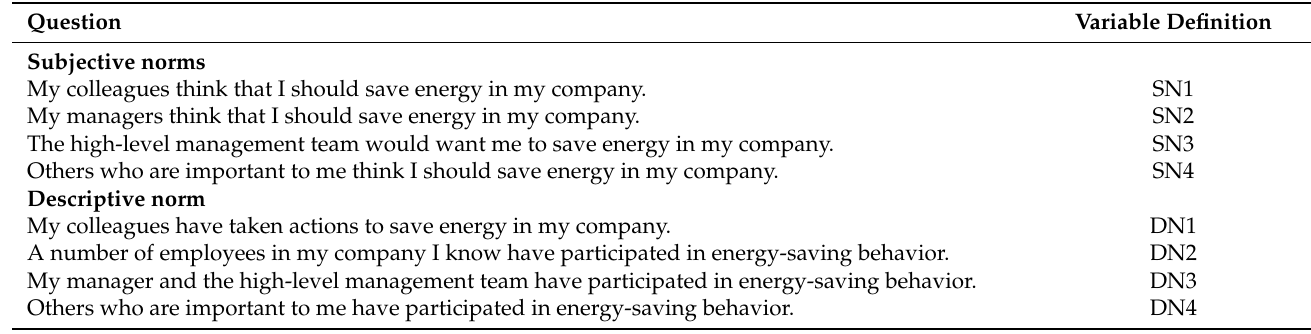
Table A1. Questionnaire and Variable